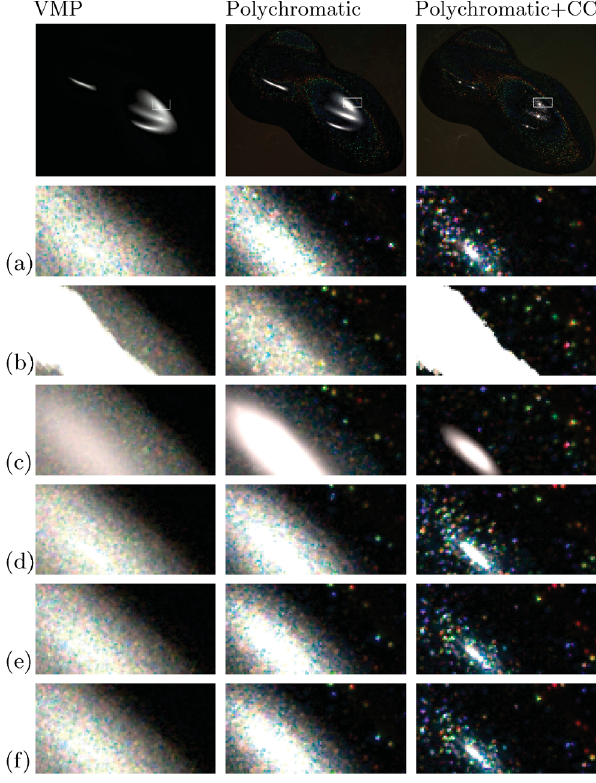
Fig. 11 Comparison between captured spatially-varying represen- tations and ground-truth measurements: (a) per-pixel ground-truth measurements, (b) raw BTF measurements, (c) BTF measurements with the specular highlight represented by the Fresnel reflection, (d) isotropic measurements, (e,f) bivariate isotropic measurements for ϕ d = 90 ◦ and steps Δ θ h / Δ θ d = 2 ◦ / 2 ◦ and 5 ◦ / 15 ◦